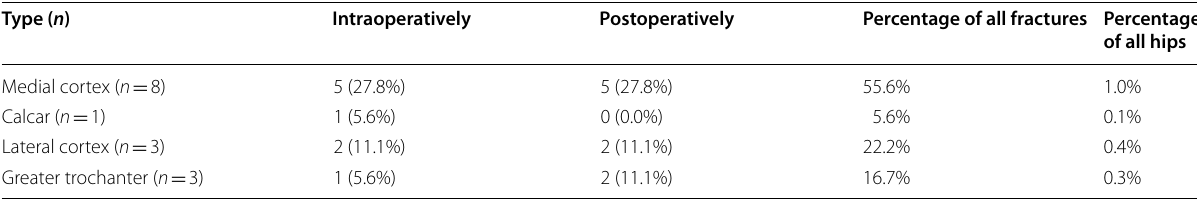
Table 2 Type of PFFs and time of occurrence/diagnosis